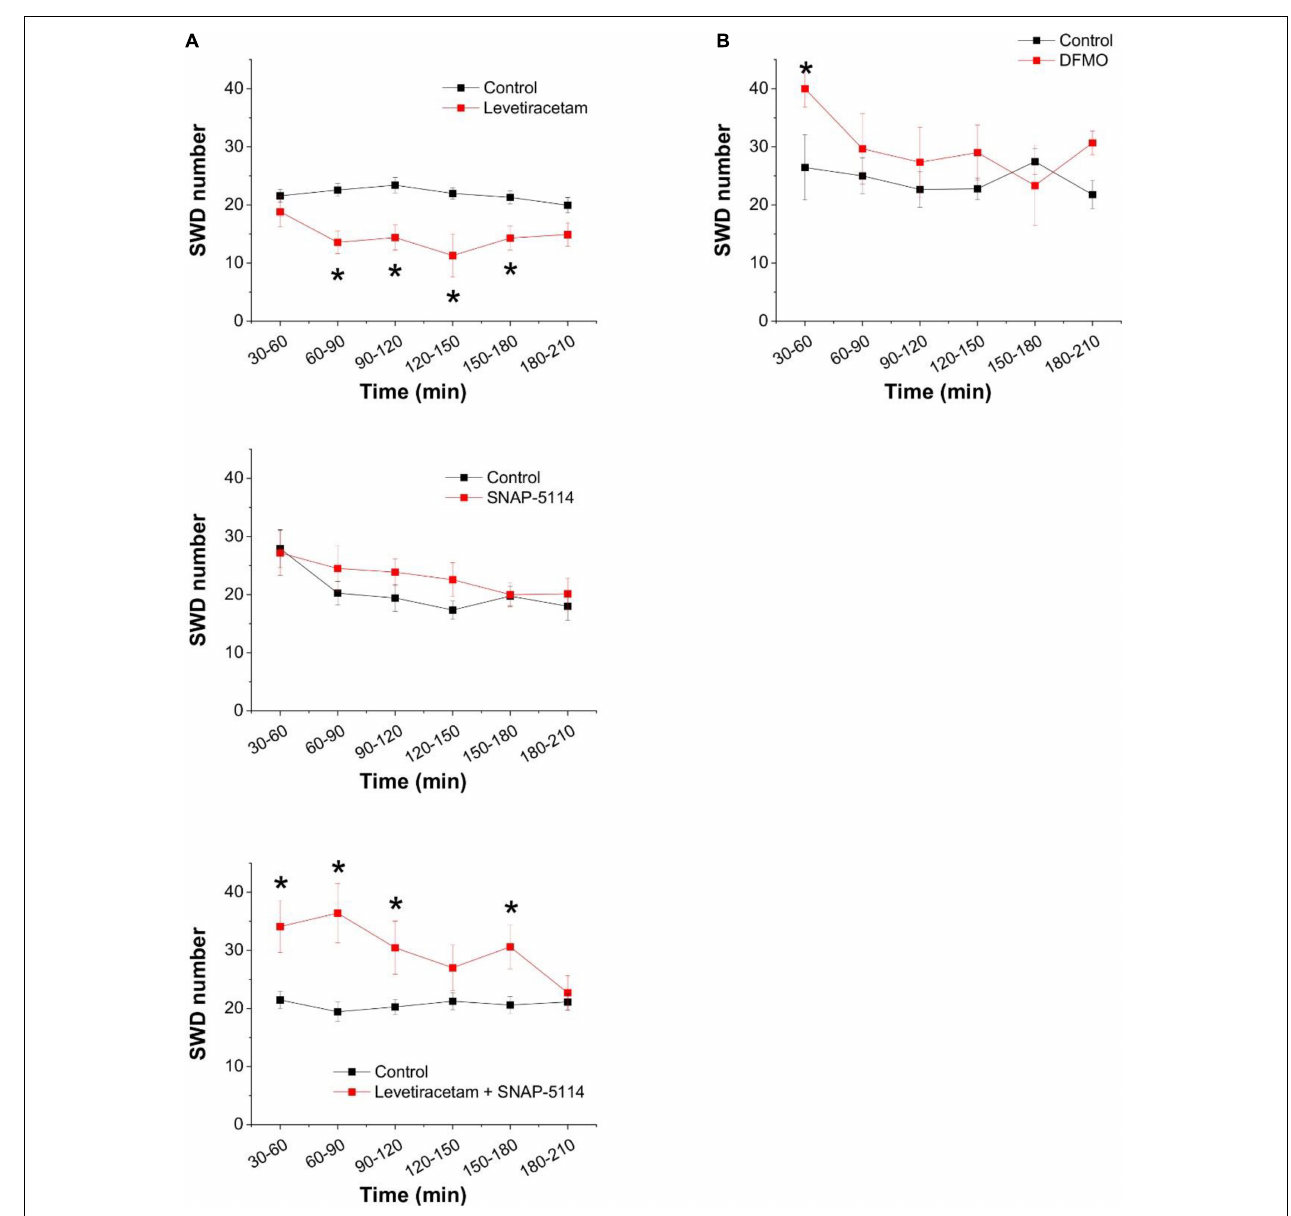
FIGURE 5 | Increased astrocytic GABA release through GAT-2/3 transporters suppresses spike-wave discharges in the in vivo absence epilepsy model WAG/Rij rat. (A) Effect of the levetiracetam treatment (i.p. 200 mg/kg/day, 5 consecutive days, top , n = 12 animals) and the specific GAT-2/3 inhibitor SNAP-5114 (i.p. 20 mg/kg, center , n = 8 animals) on SWD numbers. Effect of SNAP-5114 (i.p. 20 mg/kg) applied on 5th day of levetiracetam treatment (i.p. 200 mg/kg, bottom , n = 12 animals) on SWD number. (B) Effect of the ornithine decarboxylase inhibitor alpha-difluoromethylornithine (DFMO, 150 mg/kg) on SWD number ( n = 6 animals). Asterisks denote significant difference from control ( p <